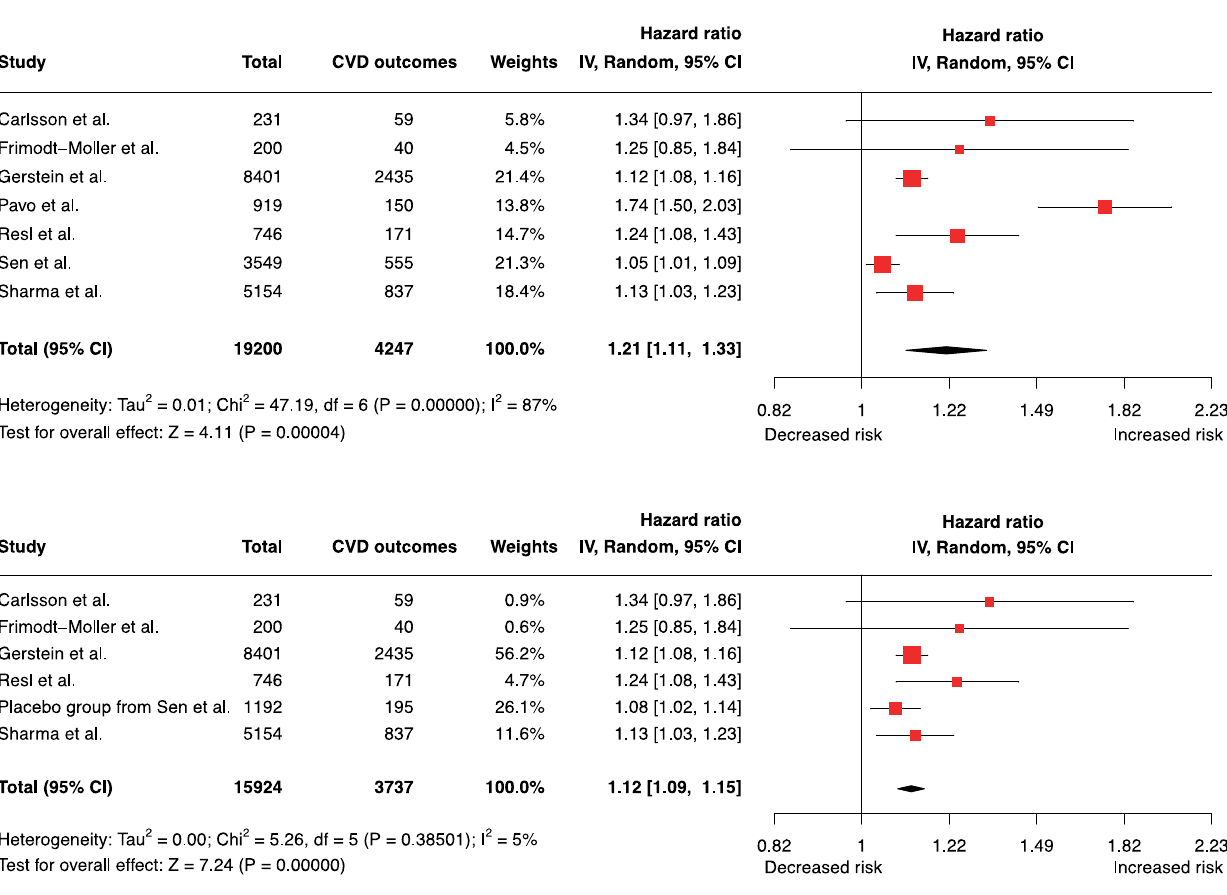
Figure 2. Elevated circulating GDF-15 levels are significantly associated with MACE. Pooled adjusted HRs are shown ( A ) with (HR 1.21, [1.11–1.33], I 2 = 87%) and ( B ) without the unadjusted study by Pavo et al. and subjects who received canagliflozin ( n = 2357 of 3549) in the study of Sen et al. (HR 1.12, [1.09–1.15], I 2 =